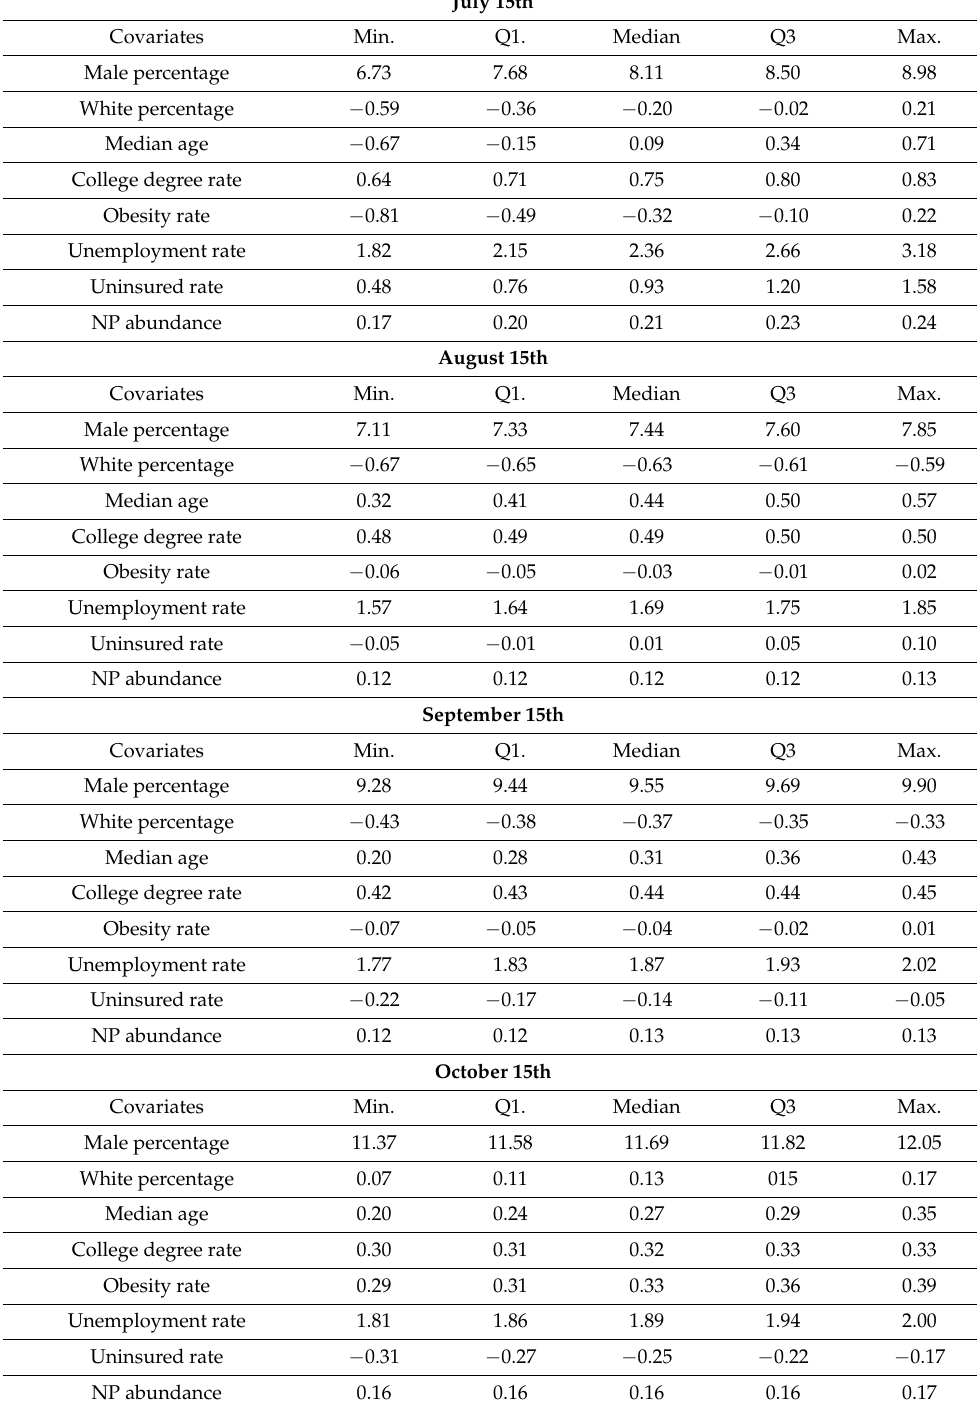
Table 5. Summary of the results from the GWR model